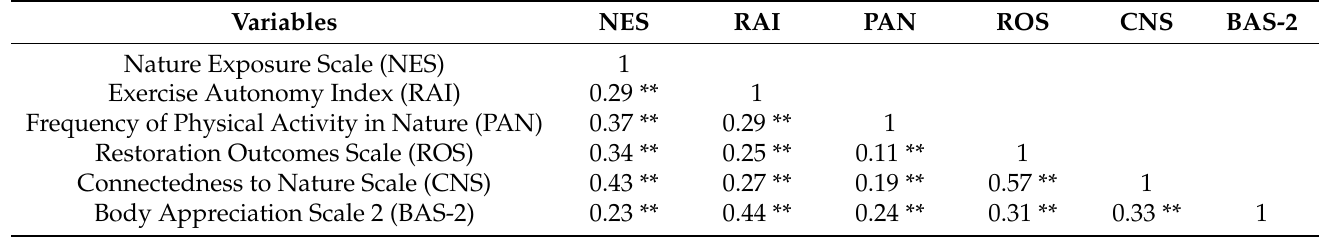
Table 3. Correlations between study variables ( n =